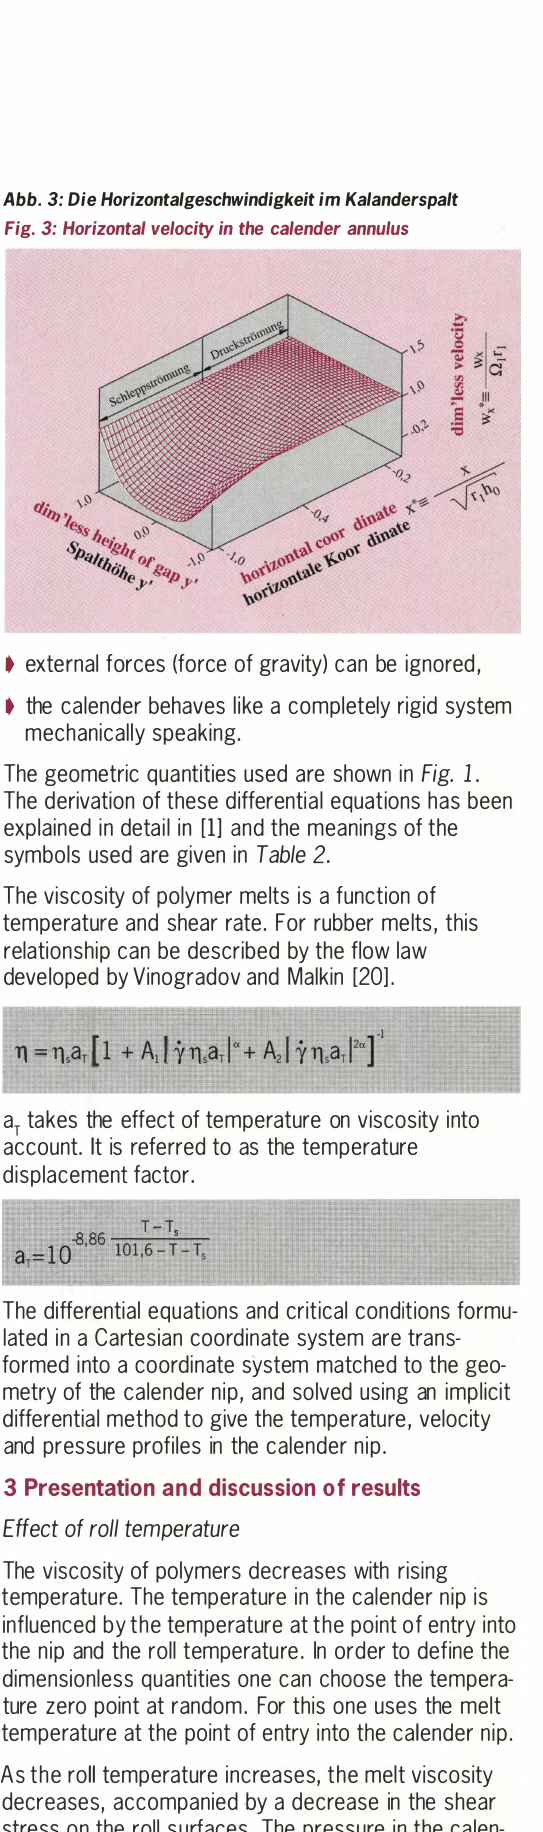
Fig. 4: Temperature in the calender annulus for a dimensionless temperature of the rolls of�·=+ 1.55 · 10"